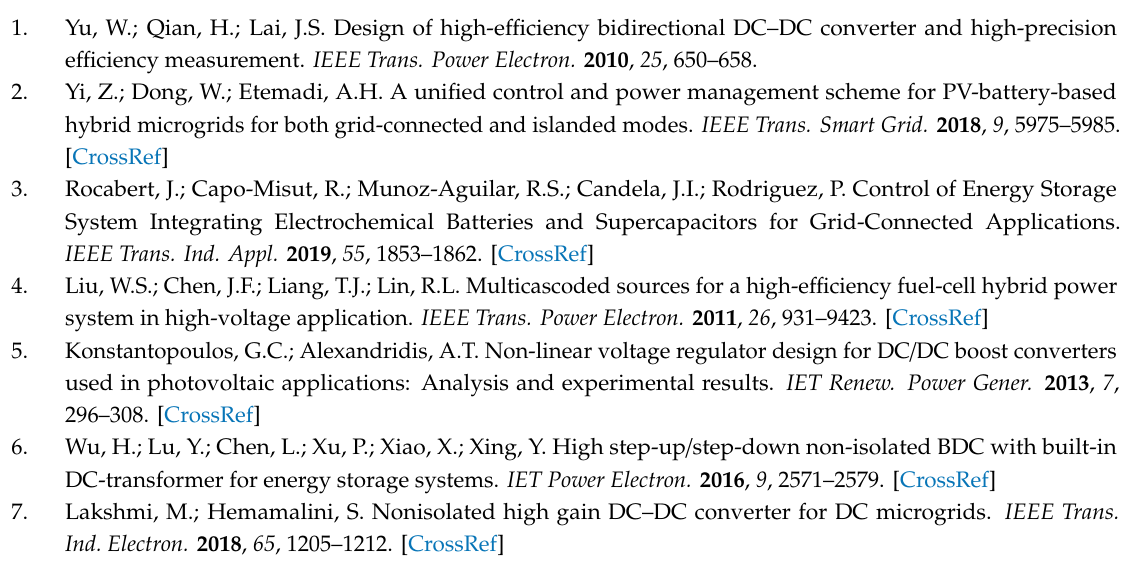
o and I o . ( V o : 100 V